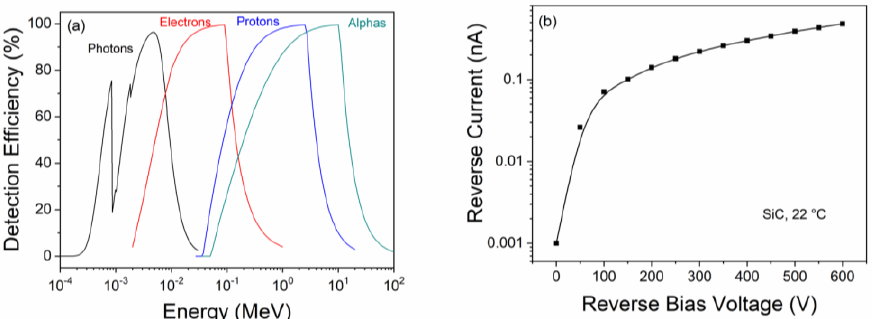
Figure 2. SiC detection efficiency versus energy for different incident radiations ( a ) and the reverse current versus the reverse bias voltage at room temperature ( b ).